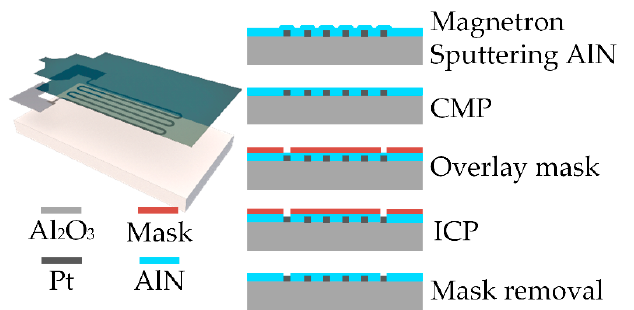
Figure 5. Process flow for the preparation of the AlN insulating and thermally conductive films.